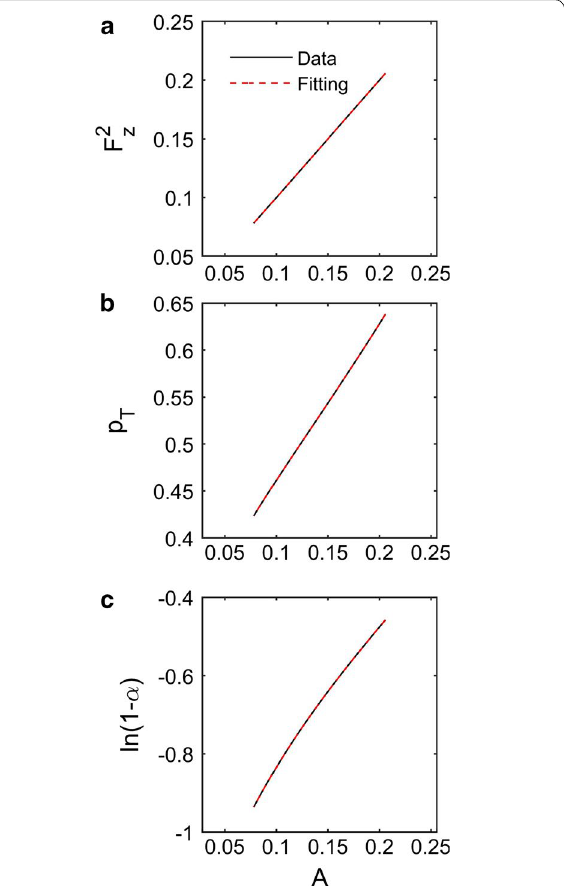
Fig. 3 Plots of three field‑line invariants a F z2 , b p T , and c ln ( 1 − α) versus vector potential for benchmark